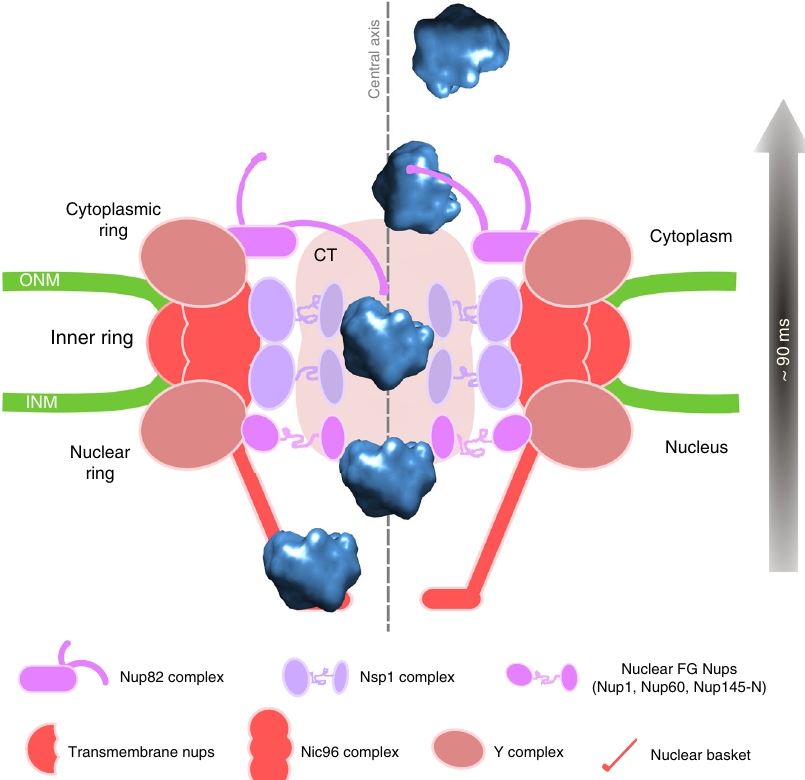
Fig. 6 Model of the translocation of pre-ribosomal particles through the NPC. A pre-60S ribosomal particle crossing the NPC is represented. After transient interaction with the nuclear basket, pre-ribosomes are rapidly transferred to the central transporter, which constitutes the main permeability barrier. The path of the particles is constrained in a narrow channel along the central axis as they cross the nuclear and inner rings. Pre-ribosomes spend a longer time in the inner ring than in the nuclear or cytoplasmic rings, maybe due to the high density of FG Nups in the inner ring (especially the Nsp1/Nup49/Nup57 complex), which provides multiple contact sites for pre-ribosomes. We postulate that extraction from this narrow channel at the exit of the inner ring involves interaction with asymmetric Nups found at the cytoplasmic ring, like the Nup82 complex. Disassembly of the nuclear transport factors then makes transport irreversible. This path is consistent with the requirement of the Nsp1 and the Nup82 complexes for pre-ribosome translocation. The NPC and the pre-ribosome are drawn at the same scale. CT central transporter. Modeling of the pre-60S particle is based on PDB structure 5H4P